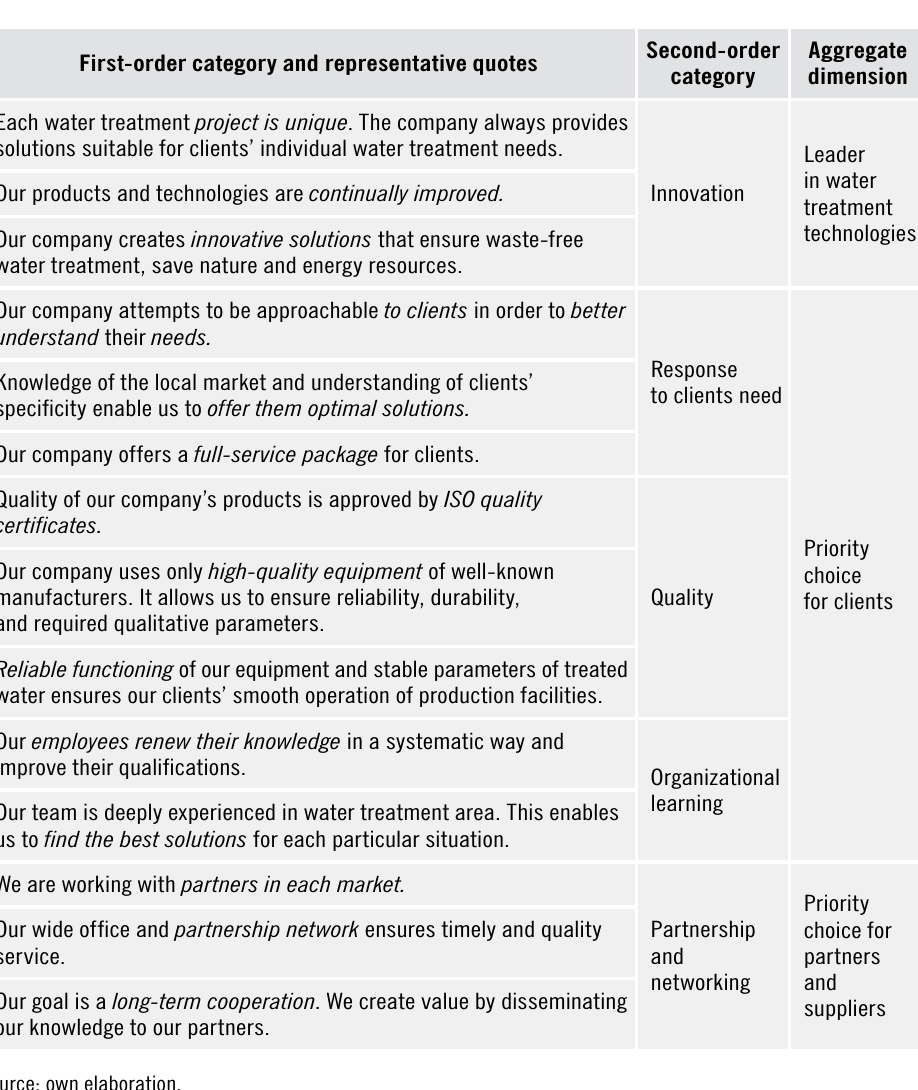
Table 4. Distinctive features of the